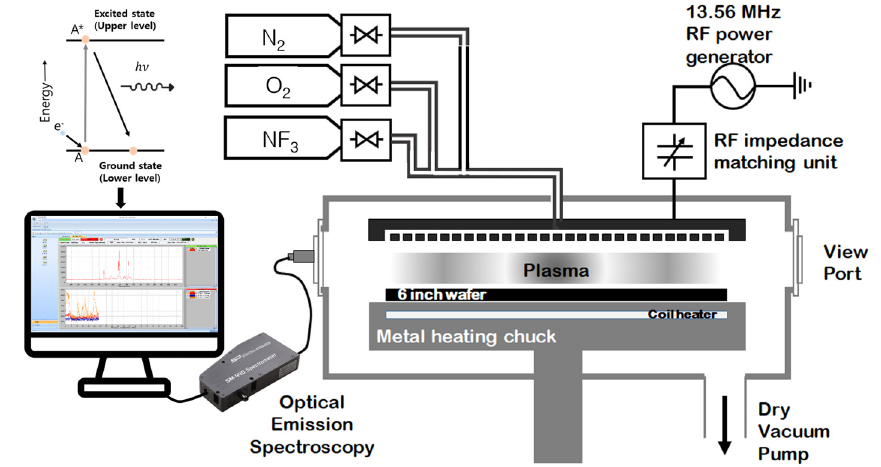
Figure 1. Experimental apparatus of a 13.56 MHz PECVD system with OES setup.